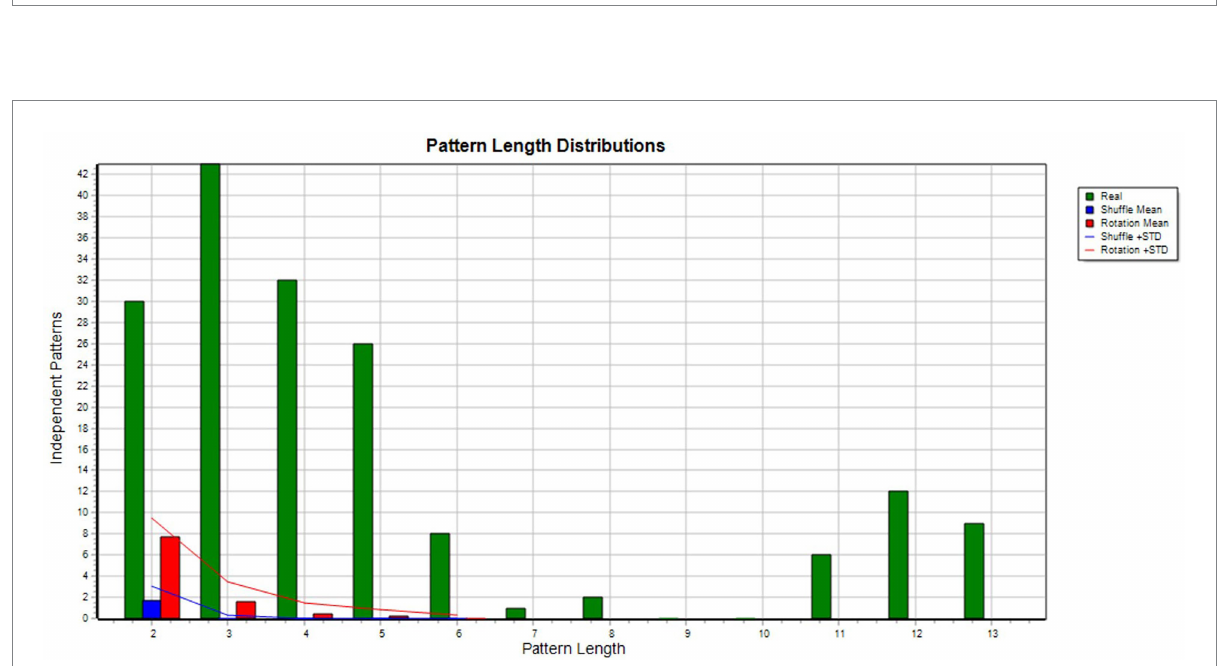
FIGURE 7 Monte Carlo test results. Shows the results of T-shuffling (blue) and T-rotation (red) for TPA of Julia and her father interactions where 169 patterns were found. The difference between real and randomized data is great and no pattern are found in the randomized data when pattern length